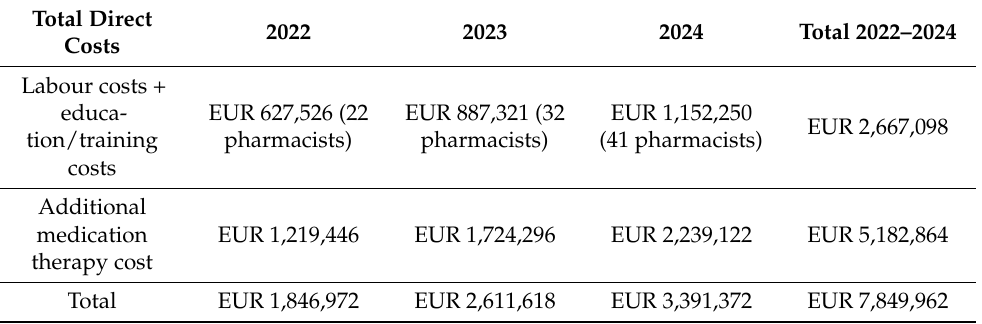
Table 9. Total costs of CMM in